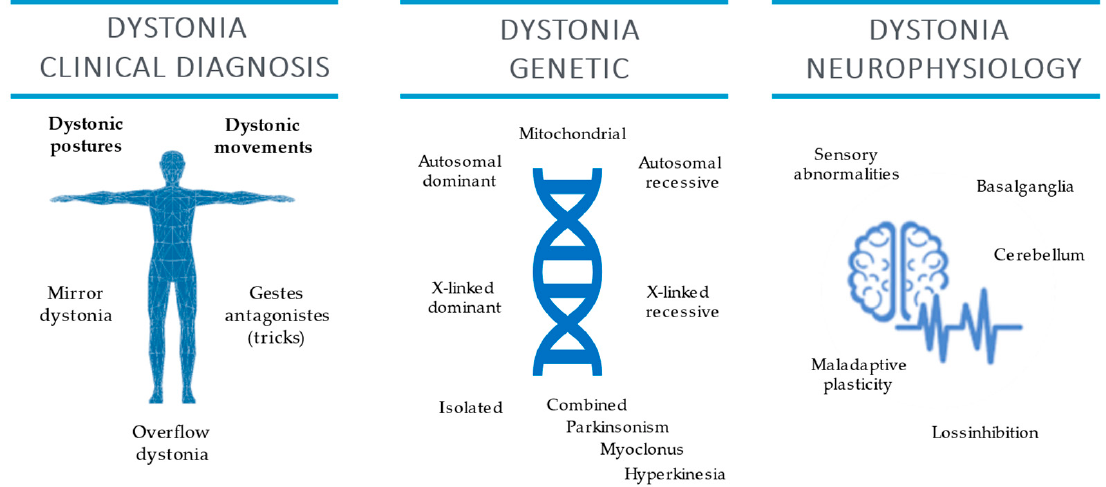
Figure 3. Dystonia clinical diagnosis and genetic and clinical neurophysiology features.